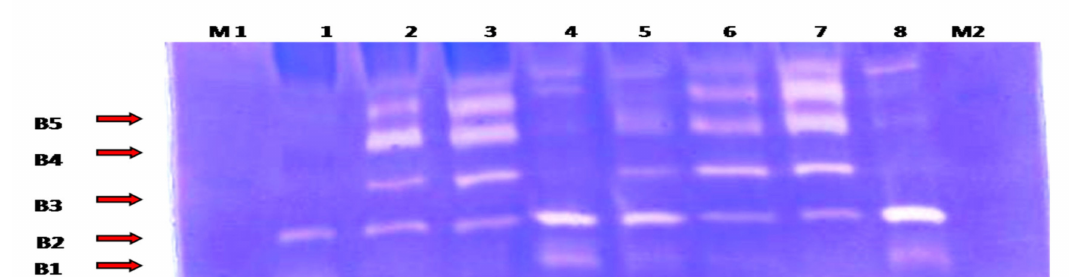
Figure 3. Heparin-enhanced gelatin zymography for MMP activity detection from the synovial fluid samples. Lane 1: represents day 0 (control) samples; lane 2: first week samples; lane 3: first month samples; lane 4: second month samples; lane5: third month samples; lanes 6 and 7: fifth month samples; and lane 8: seventh month samples. B1: corresponding to active MMP13 (48 KDa); B2: active MMP-1(57 KDa); B3: active MMP-2 (66 kDa); B4: active MMP-9 (86 KDa); and B5: latent MMP-9 (92 KDa). M1: pre-stained protein marker (10–175 KDa) (M1 was loaded at the beginning of the electrophoresis, while M2 was loaded 20min after the electrophoresis began).